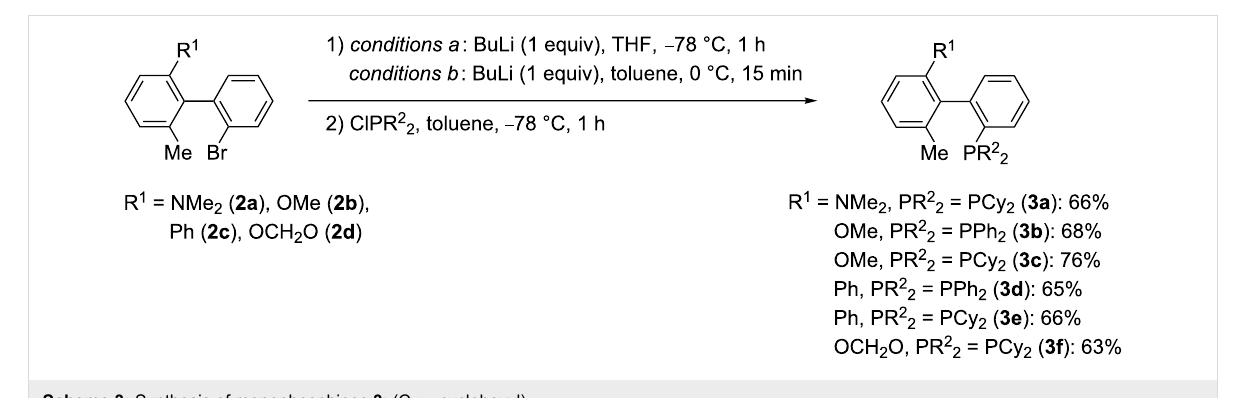
Scheme 3: Synthesis of monophosphines 3 ; (Cy =